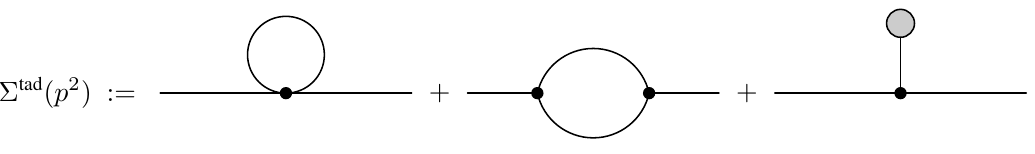
Figure 3 . Modi(cid:12)ed self-energy i (cid:6) tad ( p 2 ) in the alternative tadpole scheme, consisting of all 1 particle-irreducible (PI) self-energy diagrams together with the one-loop tadpole diagrams, indicated by a gray